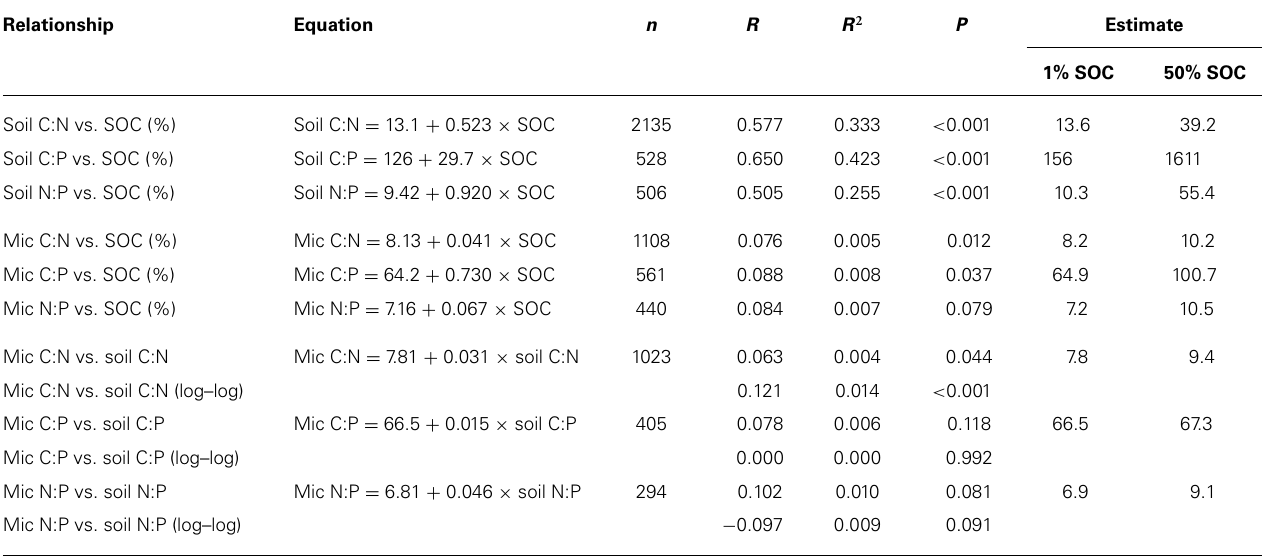
Table 2 | Relationships between soil organic carbon (SOC) content, soil C:N:P and microbial biomass C:N:P. Relationship Equation n R R 2 P Estimate